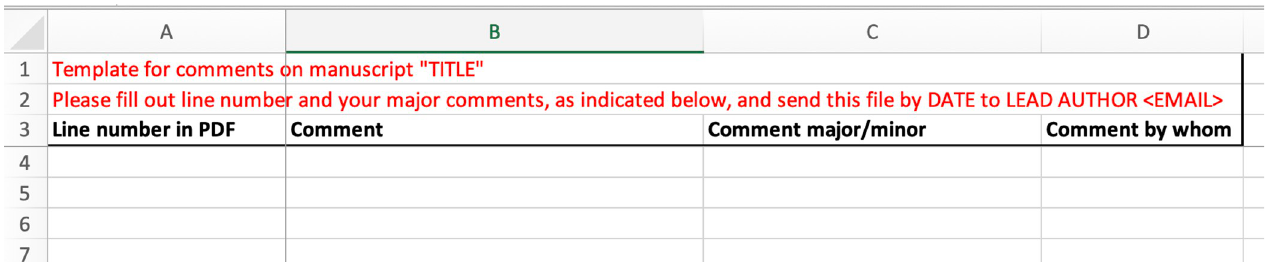
Fig 1. Example of spreadsheet template for soliciting comments from coauthors. Once filled, the spreadsheets from multiple coauthors can be combined and sorted by line number. This file is provided as S2 Table.